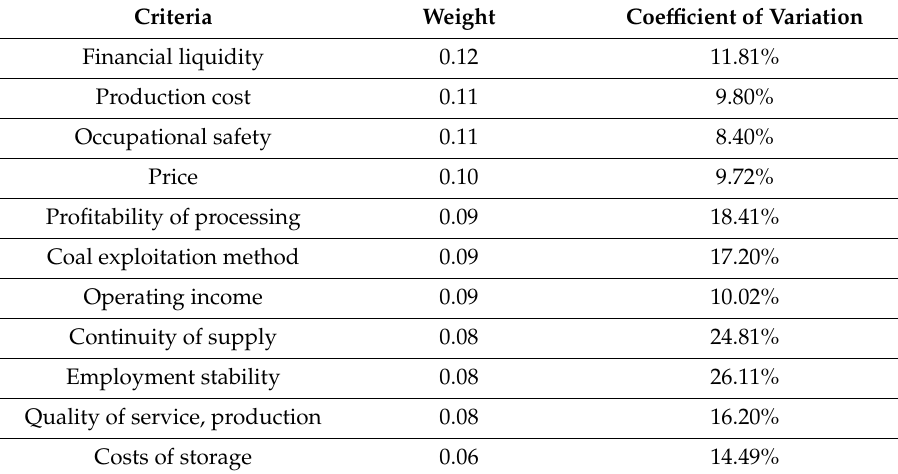
Table 1. E ffi ciency of mining companies’ assessment of criteria.